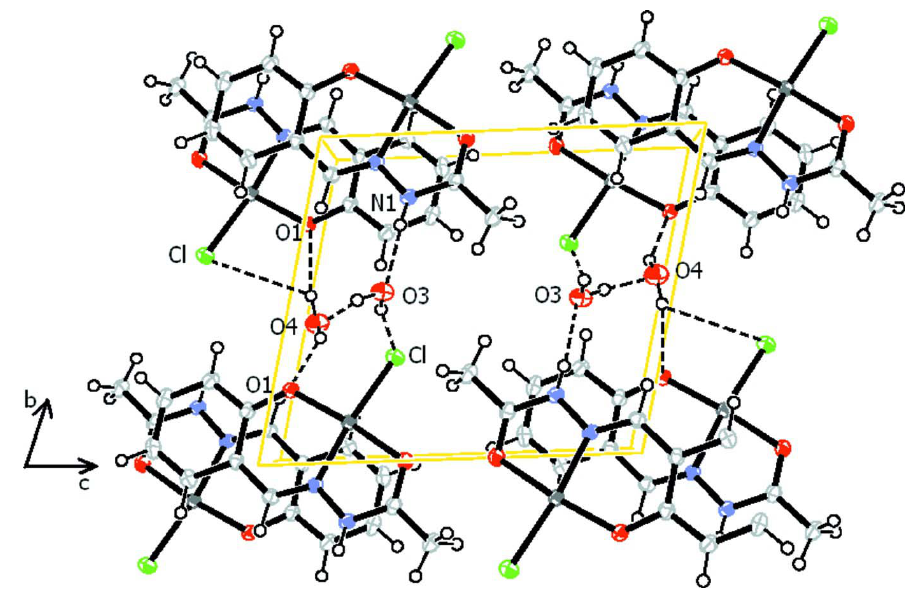
Figure 2 A view along the a axis of the crystal packing of compound (I), showing the N—H···O, O—H···O and O—H···Cl hydrogen bonds as dashed lines (see Table 2 for